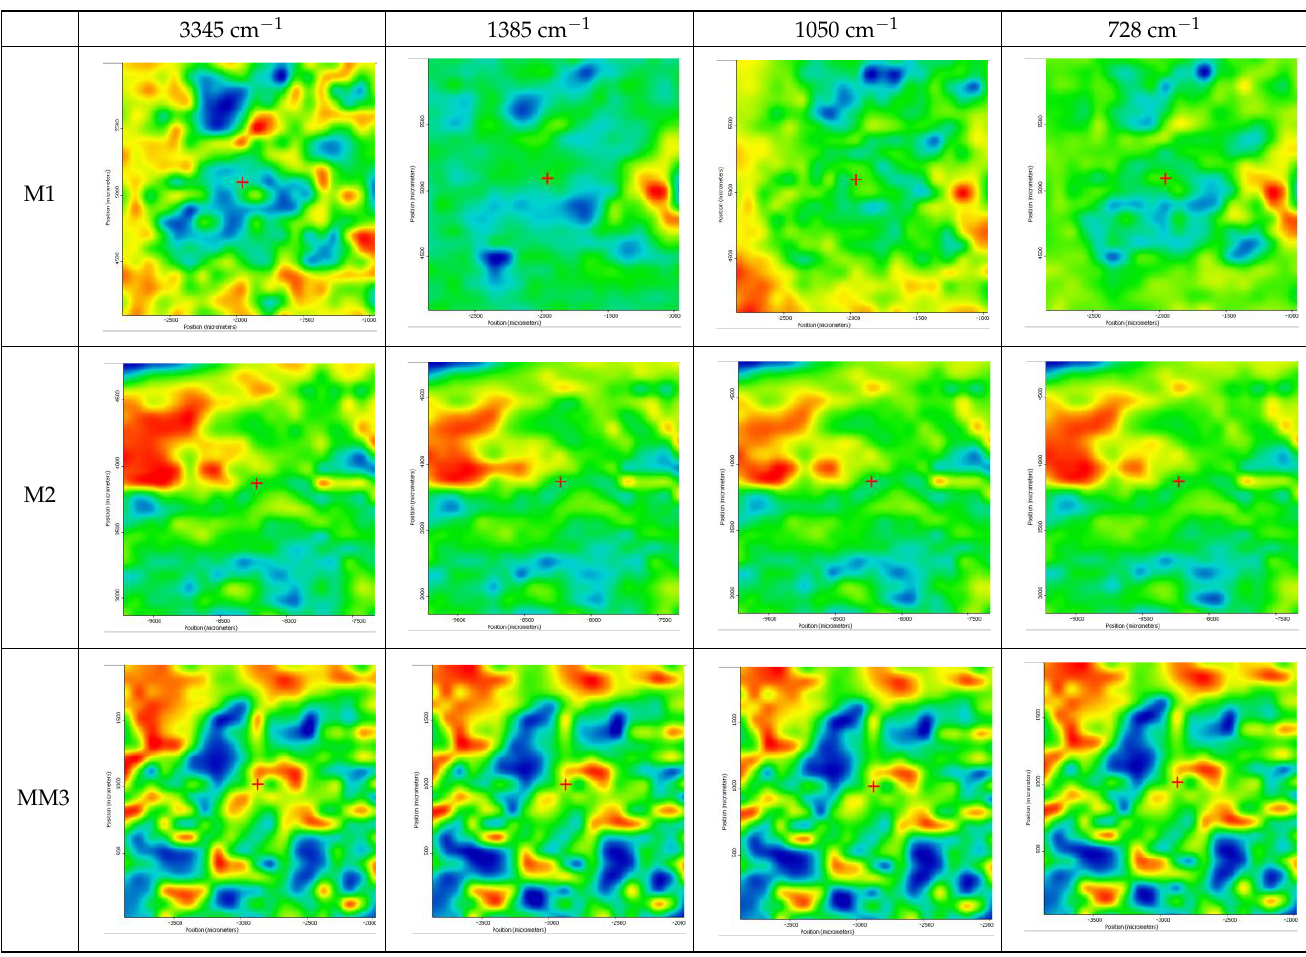
Table 4. The FTIR 2D maps for sEPDM membrane (M1) and composite membrane (M2 and M3).